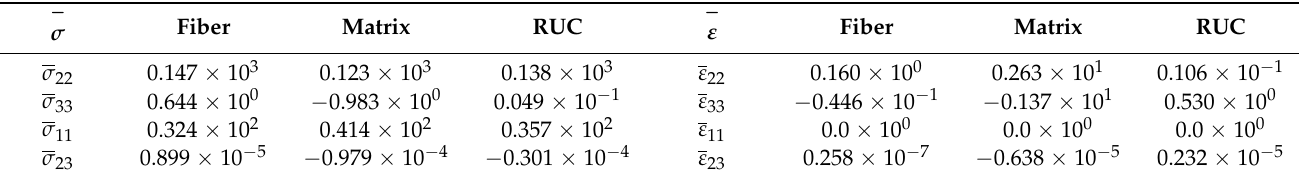
Table 5. Average values of stress and strain (Case 3).